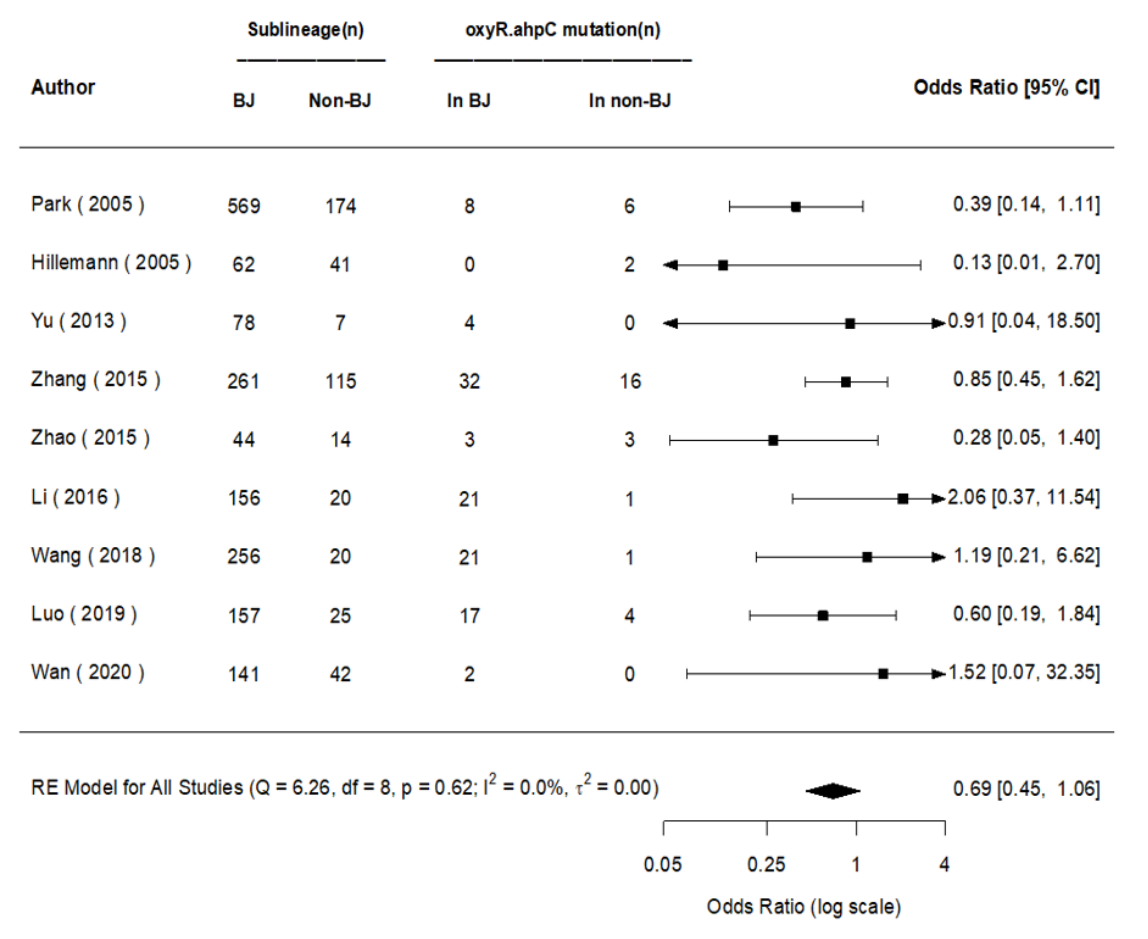
Figure 10. BMA&MA for the mutations of oxyR-ahpC in Beijing and non-Beijing strains (CI: confidence interval; BJ: Beijing strain; Non-BJ: non-Beijing strain; OxyR.C: oxyR-ahpC ).